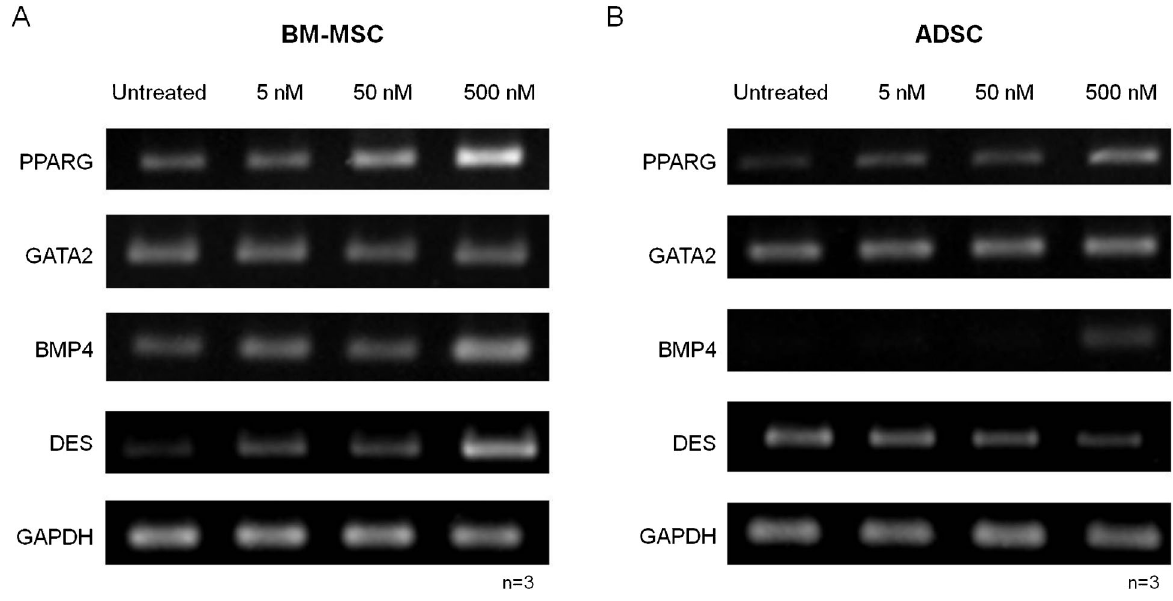
Figure 3. Effect of trichostatin A treatment (5, 50 and 500 nM) on gene expression in MSCs. PPARG, GATA2, BMP4, and DES (desmin) were analyzed by RT-PCR after 2 days of treatment. GAPDH was used as control. MSCs = mesenchymal stem cells; BM- MSCs = bone marrow MSCs; ADSC = adipose tissue stem